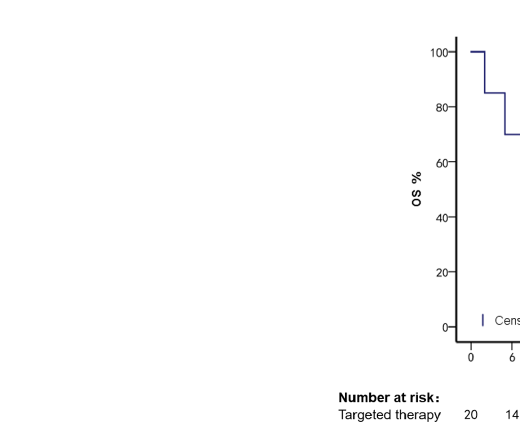
FIGURE 8 OS of Her-2 overexpressed patients after targeted therapy.